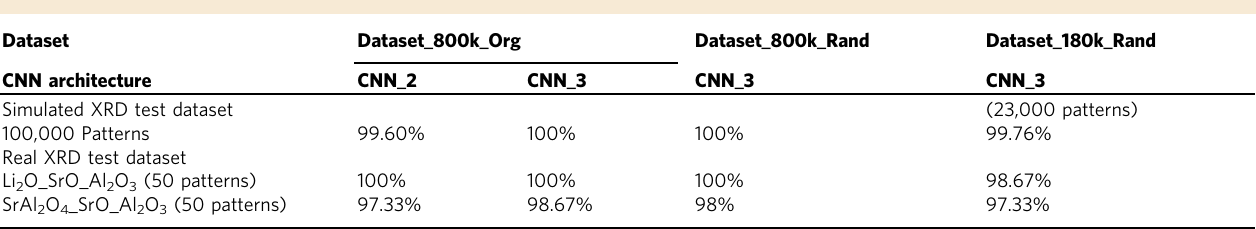
Fig. 1 The phase identi fi cation result. The training loss/accuracy (dim pink lines) and the validation loss/accuracy (deep pink lines) for both the CNN_2 ( a , b ) and CNN_3 ( c , d ) trained with Dataset_800k_org, CNN_3 ( e , f ) with Dataset_800k_rand, and CNN_3 ( g , h ) with Dataset_180k_rand are plotted as a function of the iteration number. Table 1 Phase identi fi cation test